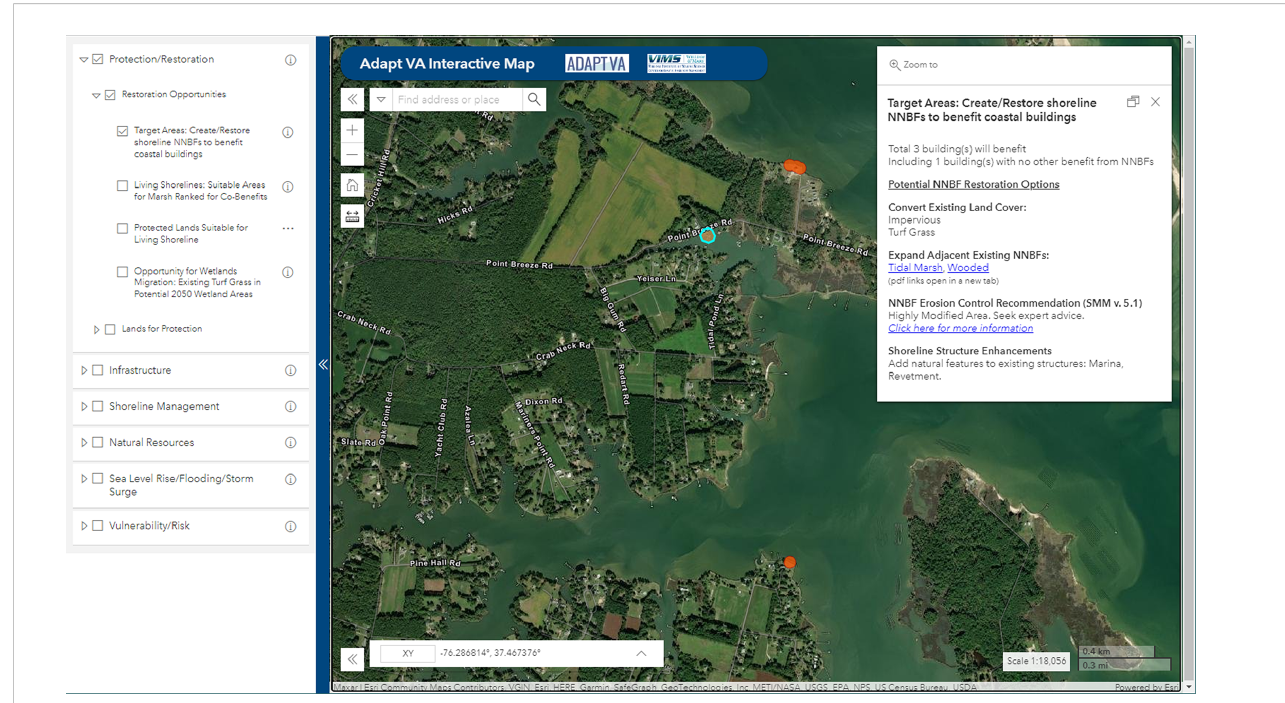
FIGURE 8 Project outputs are served on the interactive mapping tool located at AdaptVA 1 . This screenshot shows the ranked NNBF layer, located under the Lands for Protection tab, with informational popup containing information useful to managers.